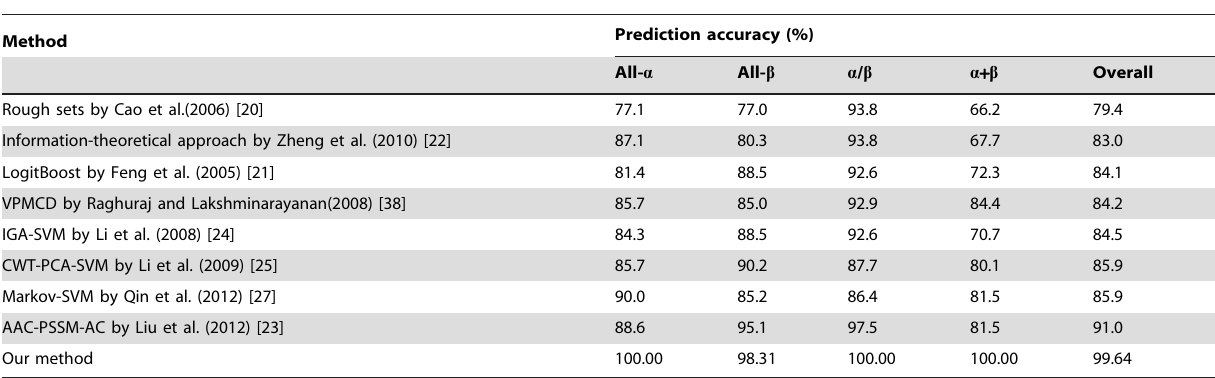
Table 8. Performance comparison of different methods on Z277 dataset.